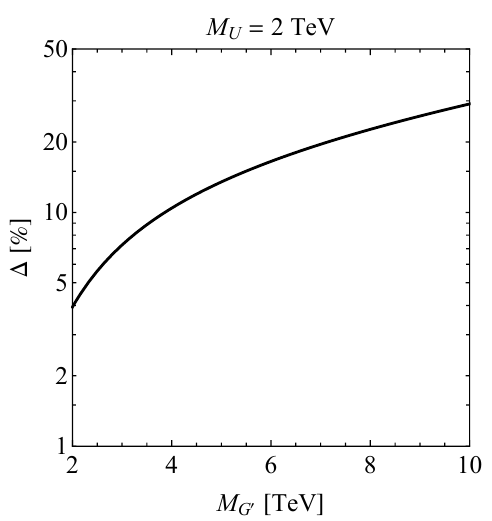
Figure 3 . Numerical size of the O ( α s ) correction to the partial decay width U → bτ as a func- tion of the coloron mass M G 0 , fixing the singlet vector LQ mass to M U = 2 TeV . See main text for further